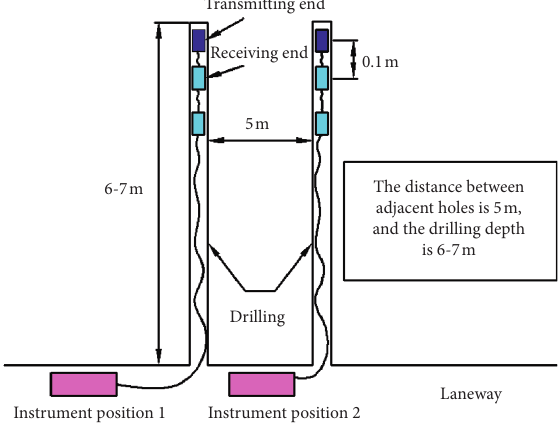
Figure 12: Arrangement of roadway surrounding rock damage detection stations.